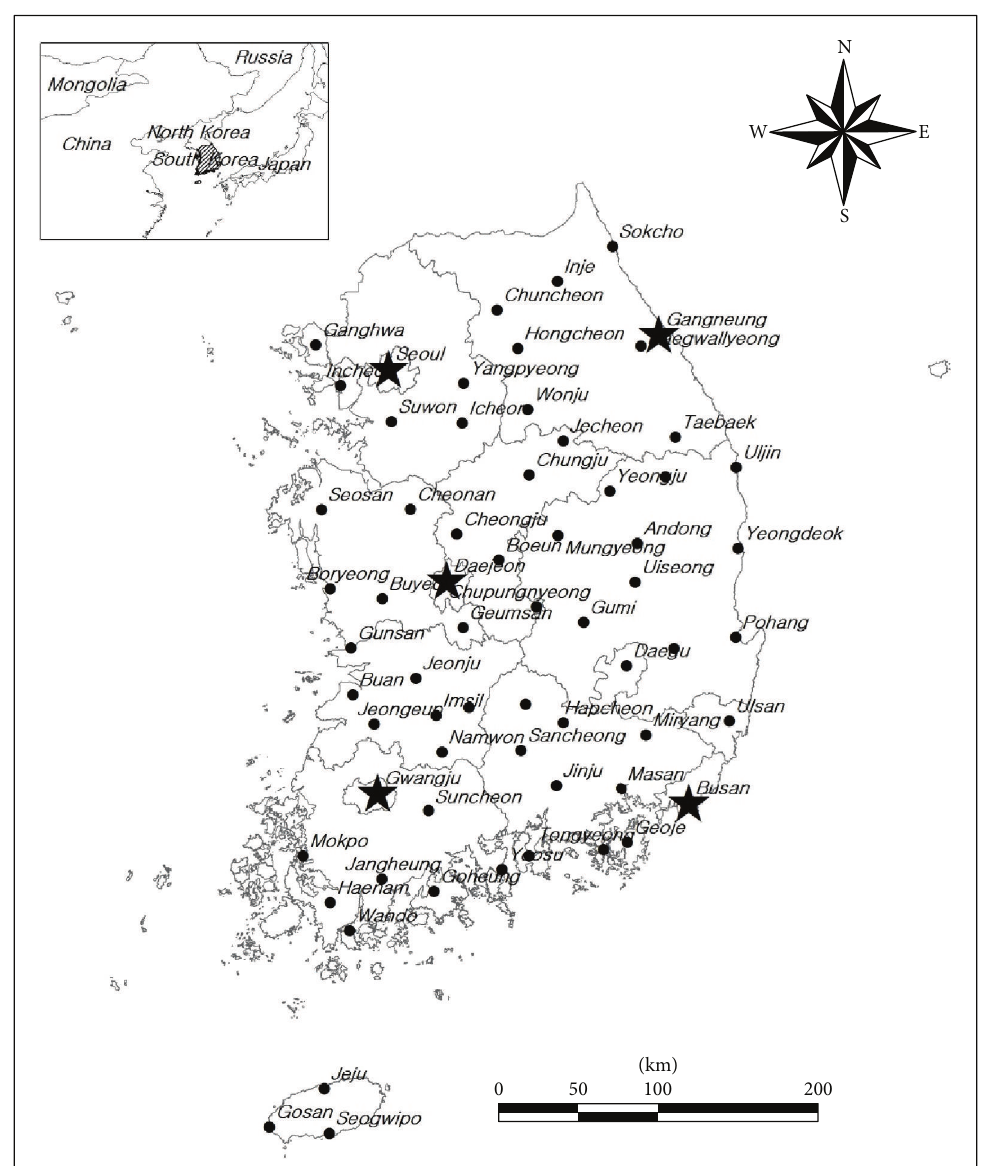
Figure 1: Location of the 65 precipitation gages in Korean Peninsula operated by the Korea Meteorological Administration.